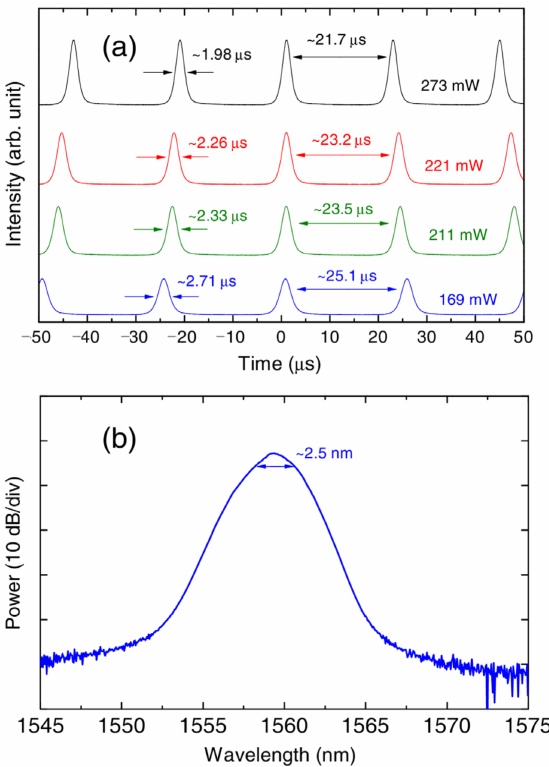
Figure 21. ( a ) Oscilloscope traces of output pulses measured at various pump powers. ( b ) Optical spectrum of output pulses obtained at a pump power of 273 mW. Reprinted with permission from